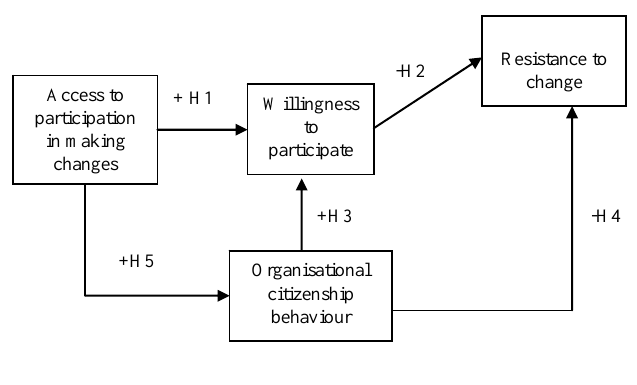
Figure 1: Hypothesised model - Extra-role performance, participation and change